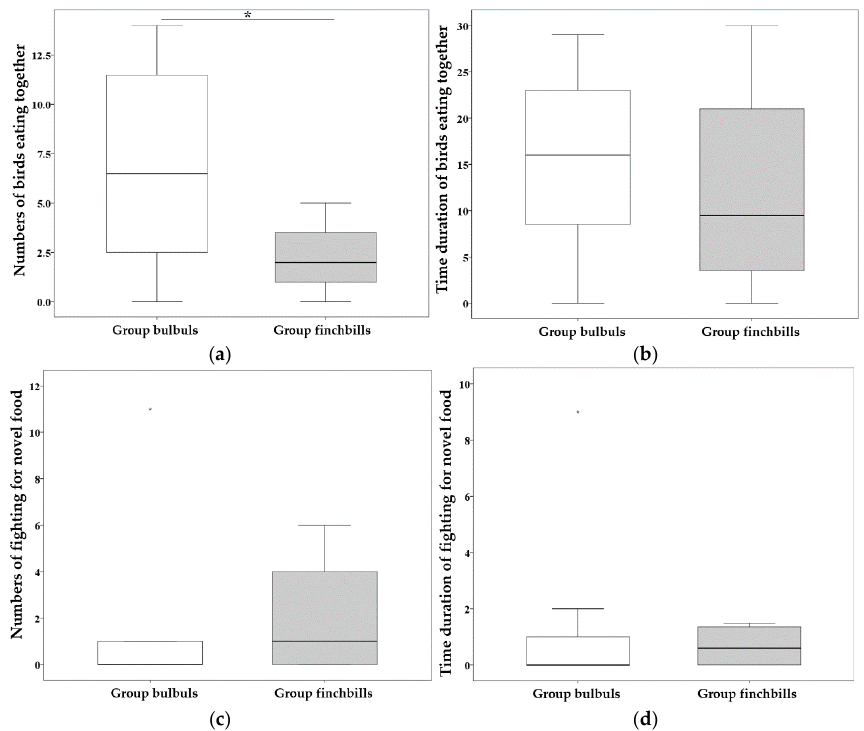
Figure 4. Boxplots of shared novel foods by more than two birds and fights for novel food between Light-vented Bulbuls ( n = 4) and Collared Finchbills ( n = 4) when foraging socially (G). ( a ) Number of times more than two birds ate novel food together (C), line and asterisk(s) above the boxplots indicate statistically significant differences between the two groups.; ( b ) time duration of more than two birds eating novel food together (CD); ( c ) number of fights for novel food (F); and ( d ) time duration of fights for novel food (FD). Bars show the maximum observed value (upper part) and the minimum observed value (lower part). Upper edge of the box shows the upper quartiles (Q3), while the lower edge of the box shows the lower quartiles (Q1). The middle line in the box shows the median. Abnormal values are shown as asterisks for extrema above the boxplots but under the line.